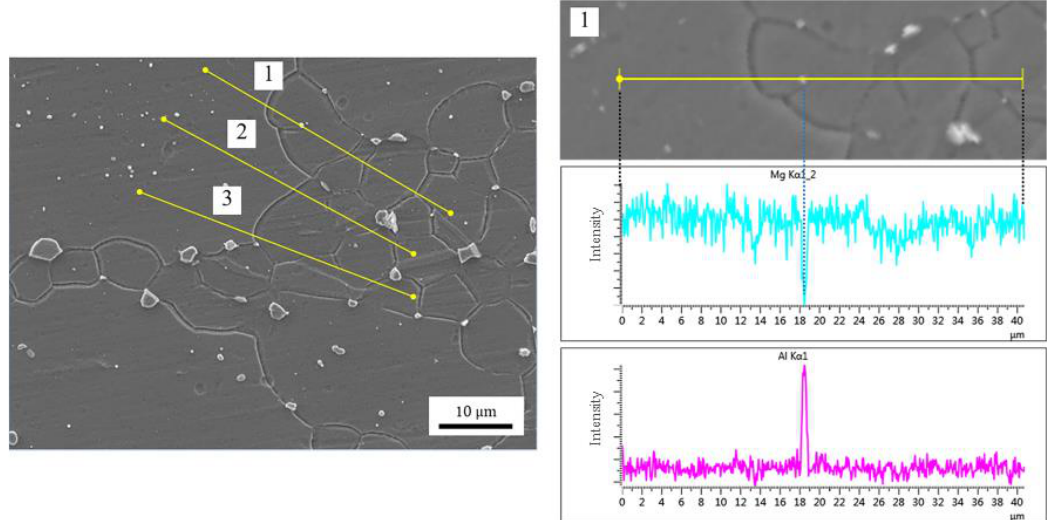
Figure 17. The distribution of solute Al within abnormal and normal grains was measured by lin- ear EDS for samples annealed at 350 °C. 1, 2 and 3 represent different positions of the linear EDSs.